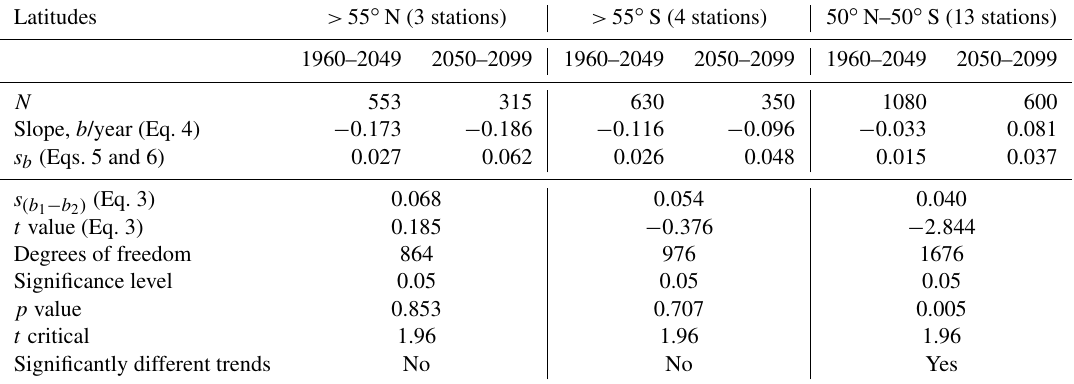
Table 5. Statistical test results for the difference between two trends in DNA-active irradiance (trend of 1960–2049 minus trend of 2050– 2099), for the northern high-latitude stations ( > 55 ◦ N), the southern high-latitude stations ( > 55 ◦ S), and the stations between 50 ◦ N–50 ◦